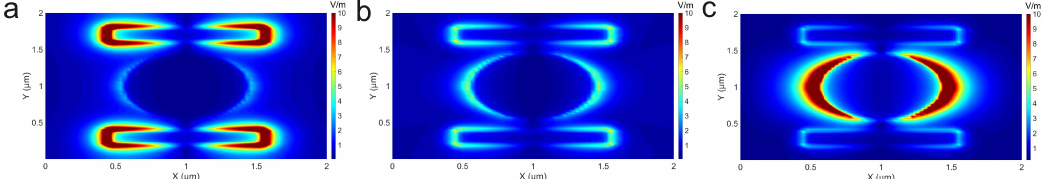
Figure 3. Electric-field (E-field) magnitudes at 0.5 eV: ( a ) E-field magnitude at 3.62 µ m. ( b ) E-field magnitude at 3.94 µ m. ( c ) E-field magnitude at 4.39 µ m.